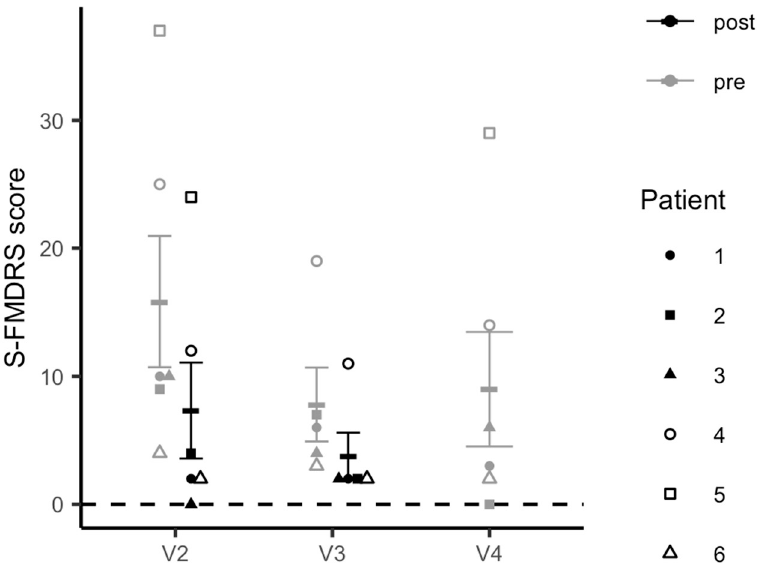
Figure 5. Changes in Simplified-Functional Movement Disorder Rating Scale (S-FMDRS)